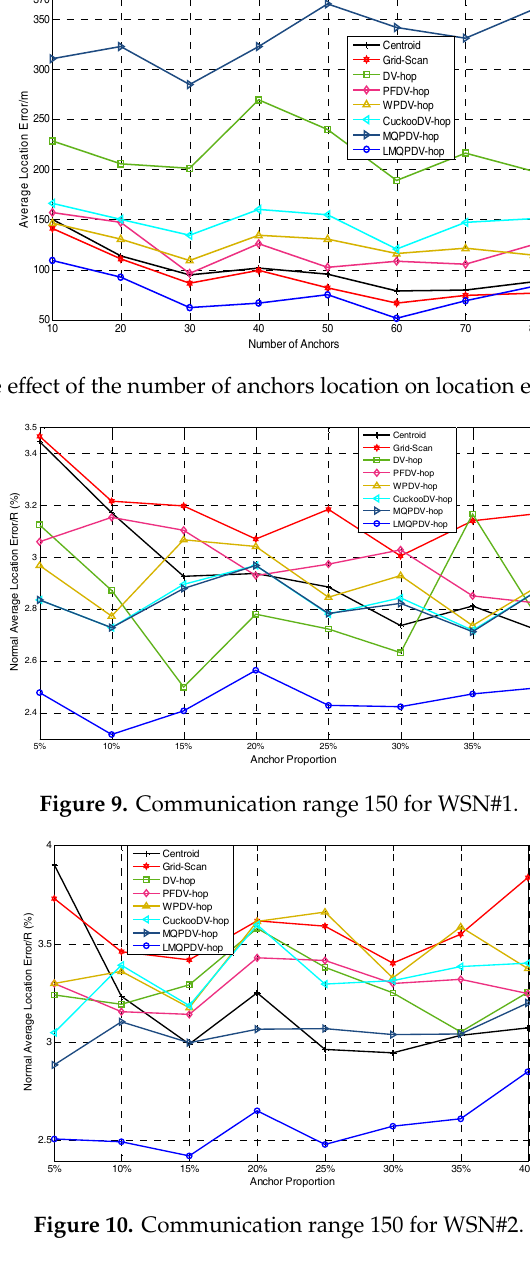
Figure 11. Communication range 200for WSN#1.